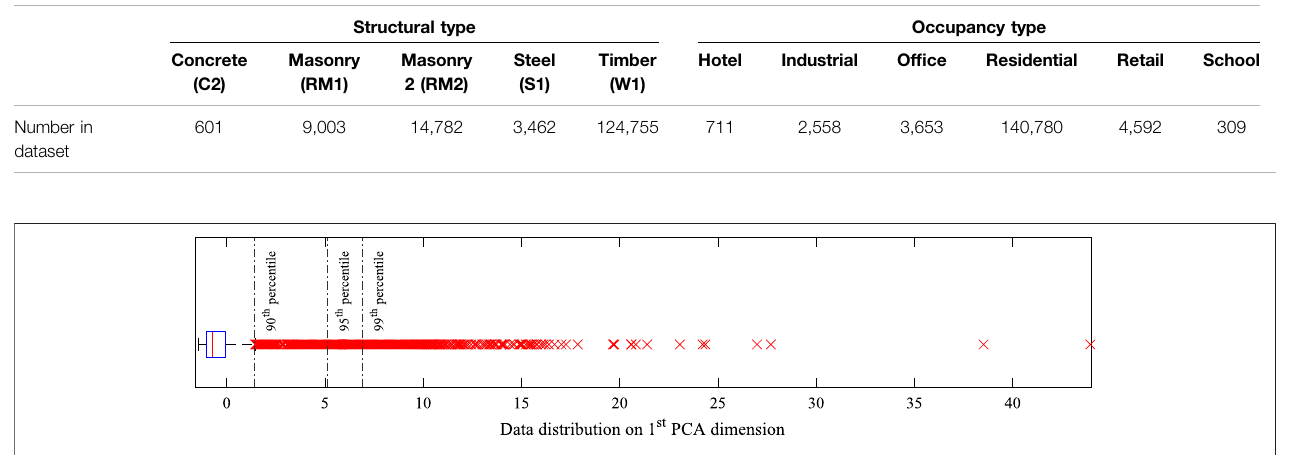
TABLE 1 | Number of buildings in different categories of structural type and occupancy.